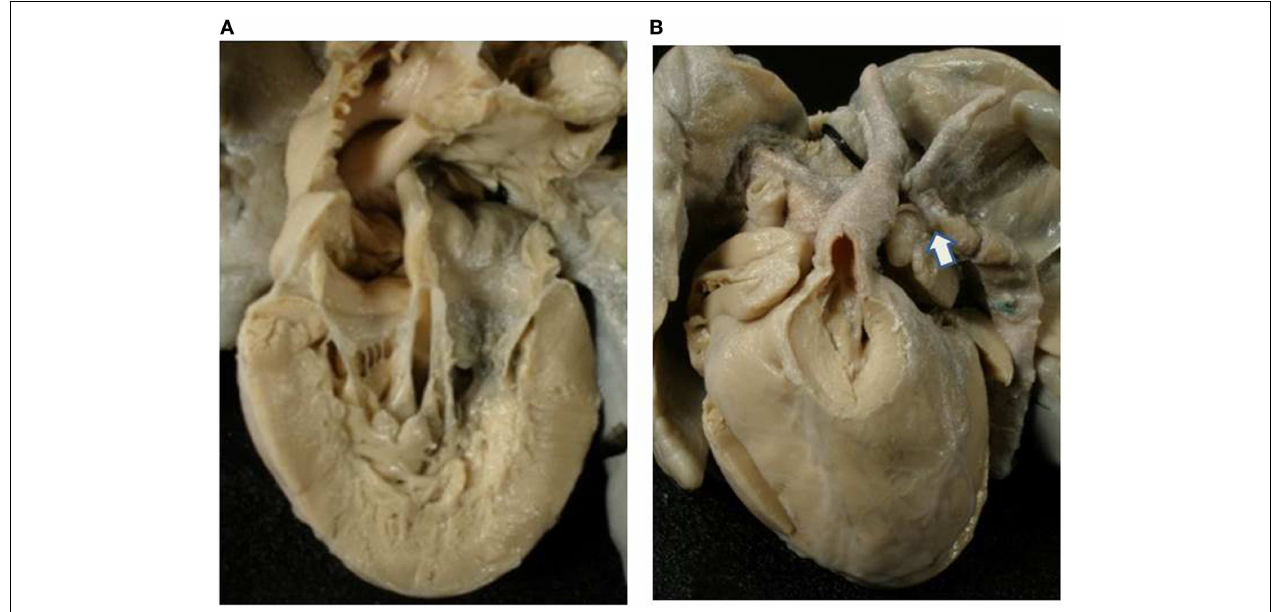
gives origin to the aorta (discordant ventriculo-arterial connection). Note the restrictive ventricular septal defect (bulbo-ventricular foramen).The arrow indicates the surgical repair of the aortic arch